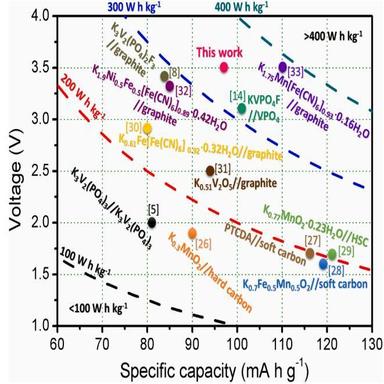
Electrochemical performances comparison of KVPF@C-MC2//HC with previously reported K-ions full-cells. Calculations are based on the cathode materials mass.